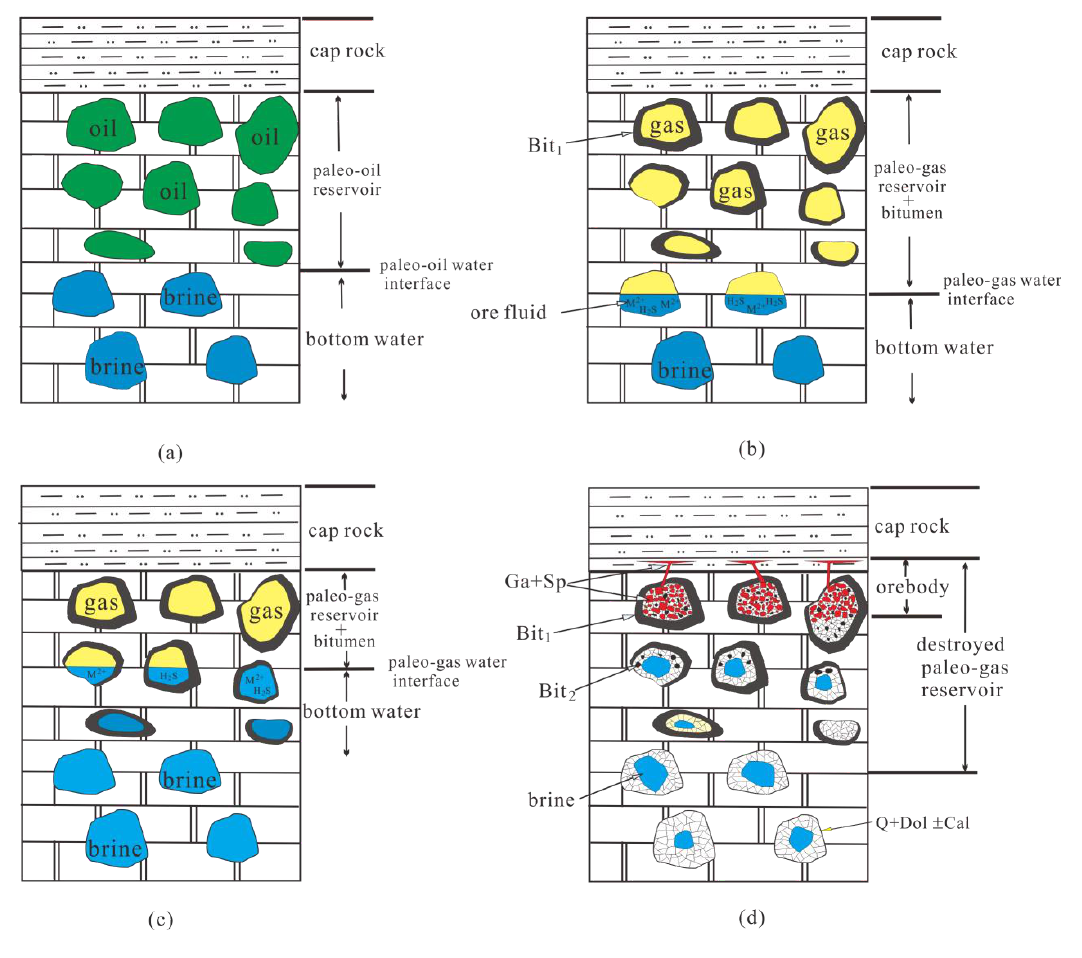
Figure 11. Schematic diagram of hydrocarbon accumulation and mineralization processes. ( a ) Pe- troleum is the initial ore-forming fluid, and hydrocarbons accumulated to form the paleo-oil res- ervoir; ( b ) In situ thermal cracking of the paleo-oil reservoir formed an overpressure paleo-gas reservoir, hydrogen sulfide was formed by TSR, and metal elements were decoupled from organic matter to form ore fluid around the gas – water interface; ( c ) The paleo-gas reservoir was destroyed, and the gas-water interface migrated upward. The ore fluid and oilfield brine migrated upward to the space after the escape of the paleo-gas reservoir; ( d ) The paleo-gas reservoir was completely destroyed, and the ore fluid mineralized to form ore minerals (galena and sphalerite) and gangue minerals (quartz, dolomite, bitumen, and calcite). Ga galena, Sp sphalerite, Bit bitumen, Q quartz, Dol dolomite, Cal calcite, M 2+ metal ions.